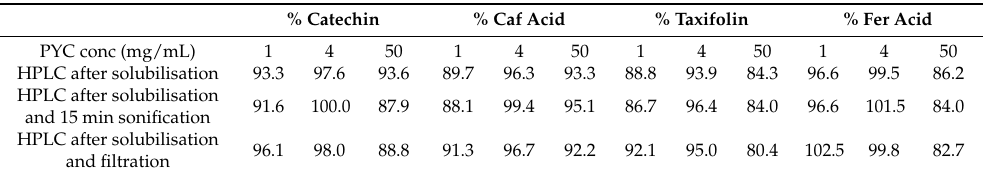
Figure 1. Fingerprint chromatogram. ( A ) 20 mg/mL PYC (Pycnogenol ® ) reference in 10% MeOH (methanol). ( B ) 50 mg/mL PYC in PBS (Phosphate Buffered Saline). Table 1. Solubility of catechin, caffeic acid, taxifolin, and ferulic acid at different concentrations of PYC (1, 4 and 50 mg/mL) in PBS (Phosphate Buffered Saline) referred to solubility in methanol (=100%) determined by high-performance liquid chromatography